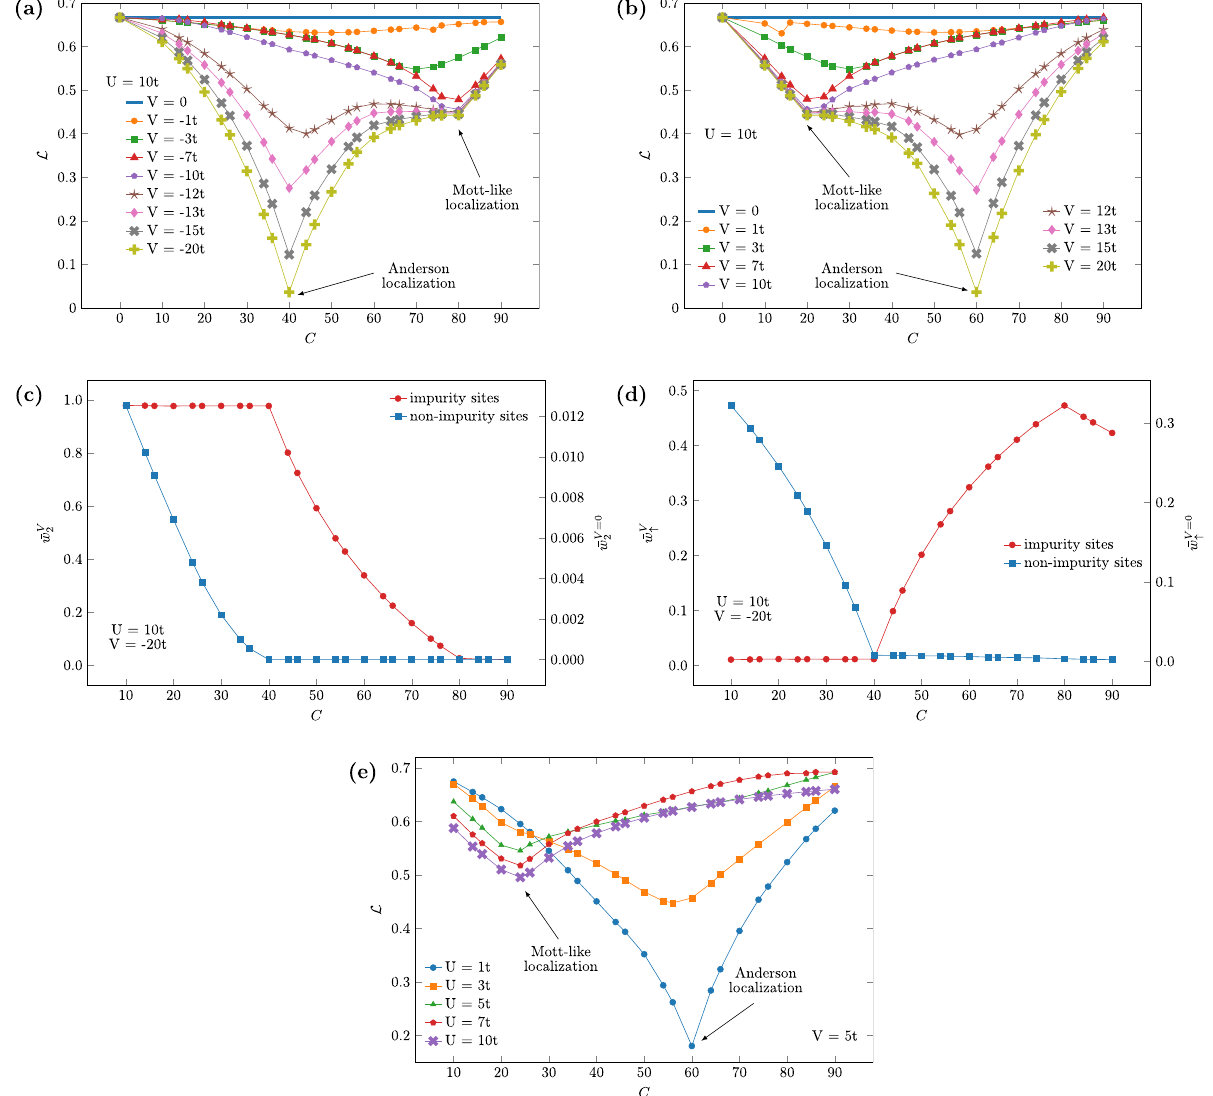
Figure 2. Entanglement of disordered nanostructures as a function of the impurities’ concentration for several attractive ( a ) and repulsive ( b ) disorder strengths at a fixed U , and for several interaction strengths at a fixed V ( c ). ( d , e ) average occupation probabilities as a function of the impurities concentration: double occupancies ( d ) and single-occupation probabilities ( e ) at impurity ( ¯ w = 100 and n = 0.8